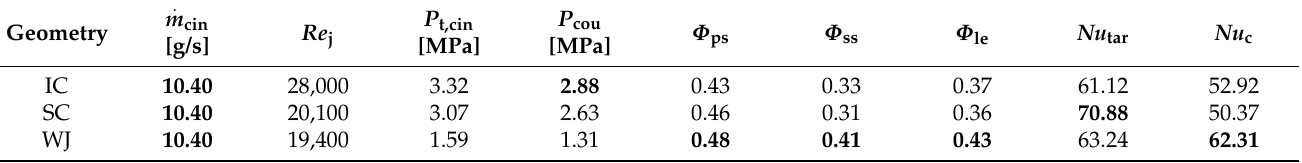
Table 3. Flow and heat transfer and parameters of the cases with the same coolant mass flow rate.